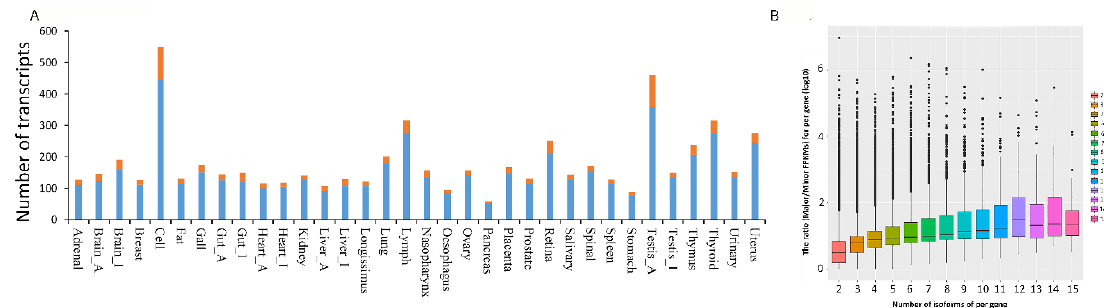
Figure 3. ( A ) Single tissue-specific transcripts. The number of known and novel transcripts that are expressed at or above 0.1 FPKM (fragments per kilobase of exon model per million mapped reads) in only one tissue and less than FPKM in all others. Blue areas represent the transcripts and related genes expressed only in one tissue (gene expression dependent). Red areas represent the transcripts expressed in one tissue, with other isoforms present in other tissues (alternative splicing dependent). ( B ) The expression of a gene with different numbers of alternative splicing. The y -axis represents the ratio = log10* (the highest FPKM/lowest FPKM) of a gene with multiple AS events, which means the greater the ratio, the greater the difference between the highest and lowest expression of a different transcript per gene. The plot represents this ratio for a gene. Table 1. Distribution of tissue ASE types in di ff erent